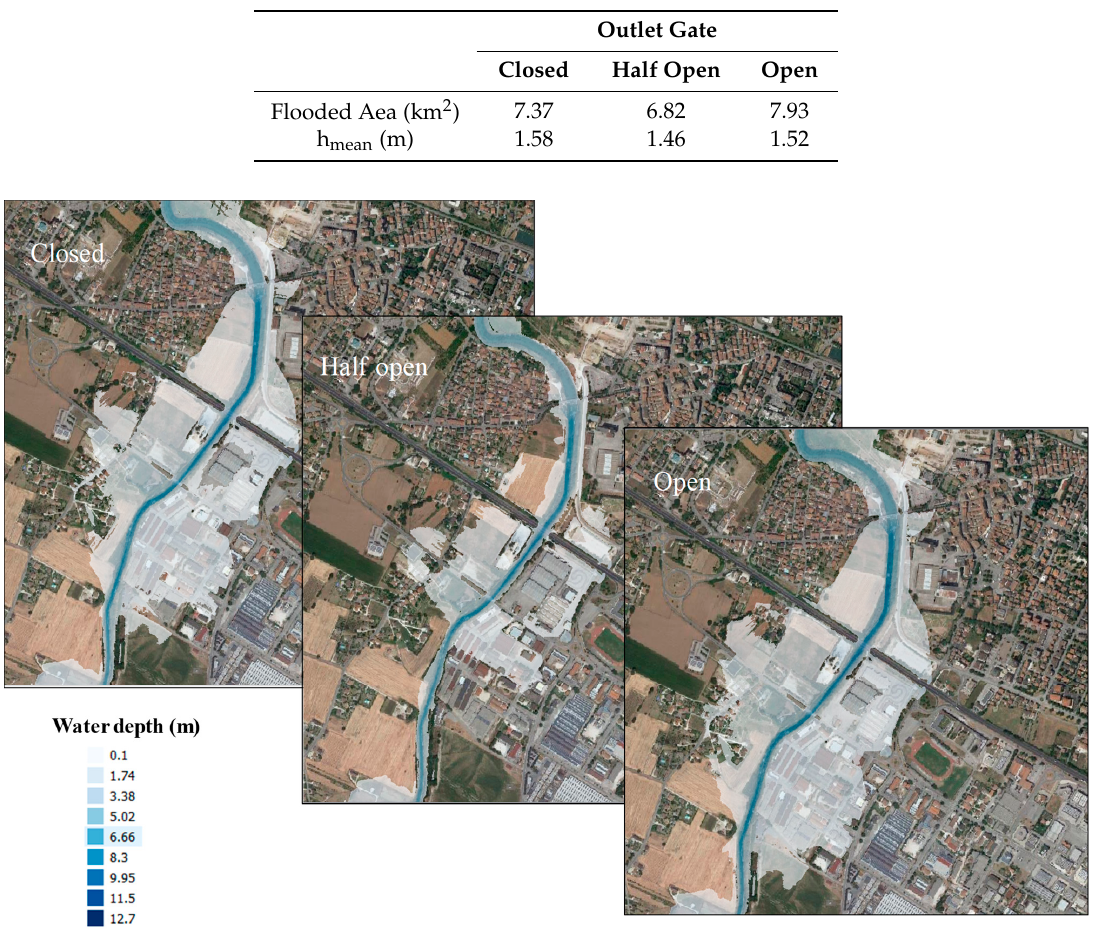
Figure 10. Three details of a flooded area for three different opening of the outlet gate (in the box on each panel) generated considering a water level in the reservoir equals to its maximum value.